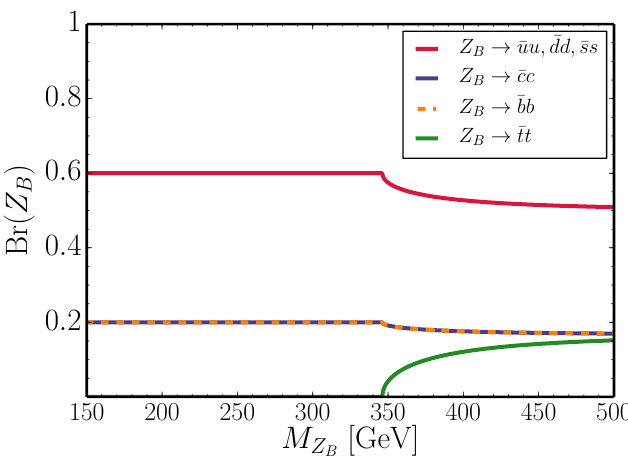
Figure 11 . Branching ratios of the Z B boson. In the parameter space where the relic density bound is satisfied, Ω h 2 ≤ 0 . 12 , the Z can only decay to quarks, and hence, the branching ratios B into different quarks is completely determined as a function of the Z B